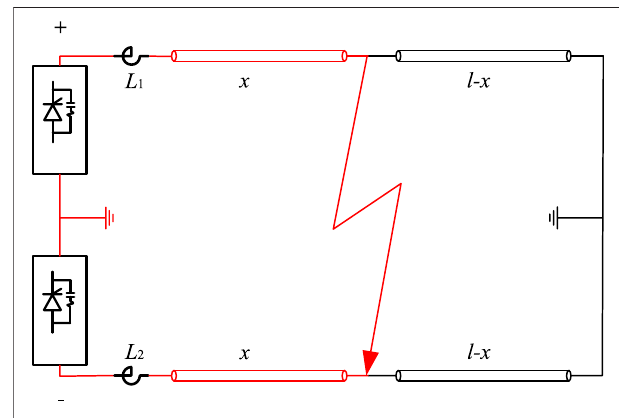
FIGURE 3 | An abnormal grounding point in the single insulated ground wire.